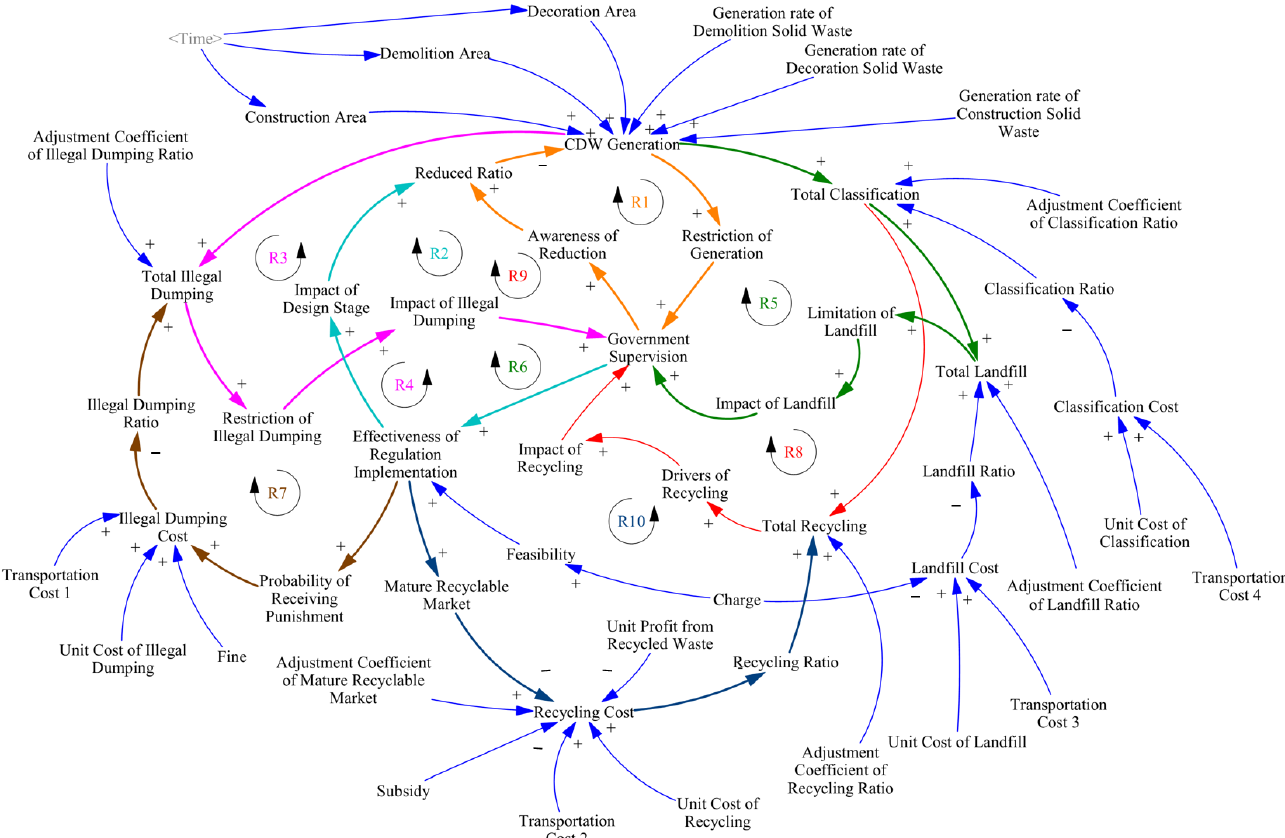
Figure 1. Causal relationship between CDW generation and disposal subsystem.